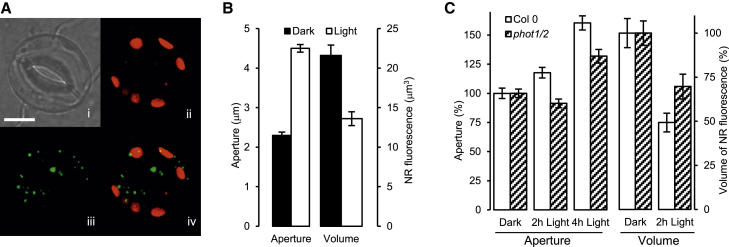
Stomatal Opening Is Associated with a Reduction in Abundance of LDs, and This Response Involves the Blue Light Receptors PHOT1 and PHOT2(A) Guard cells contain cytoplasmic NR-staining LDs (i, bright field; ii, autofluorescence; iii, NR fluorescence; iv, overlay of ii and iii; scale bar, 5 μm).(B) Light-induced stomatal opening is associated with a decrease in NR fluorescence (n = 120 for each; p < 0.001 at 4 hr for both; error bars represent ±SE).(C) Light-induced stomatal opening is disrupted in the phot1/phot2 double mutant, as is LD breakdown as estimated by NR fluorescence (n = 90 for aperture; n = 75–95 for volume; p < 0.001 at 2 hr and 4 hr for stomatal opening and p < 0.05 for LD reduction).See also Figure S1.